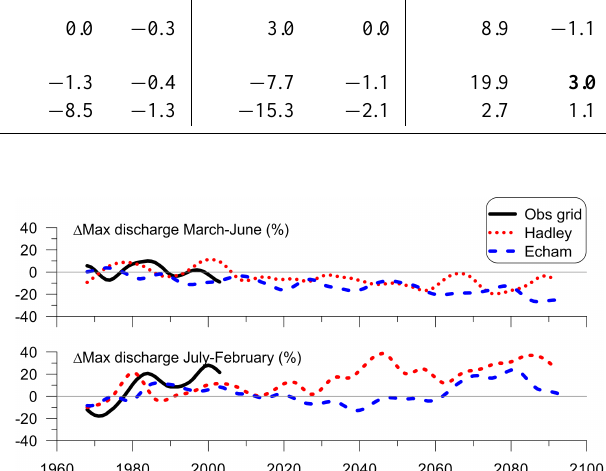
Figure 6. Modeled annual maximum daily flows during spring (top) and autumn/winter (bottom) for the period 1961–2100. Deviation (%) in magnitude versus reference period (1961–1990). The lines represent a 10-year Gauss filter for S-HYPE modeling using a forc- ing grid based on observations (Obs grid) or climate projections (Hadley and